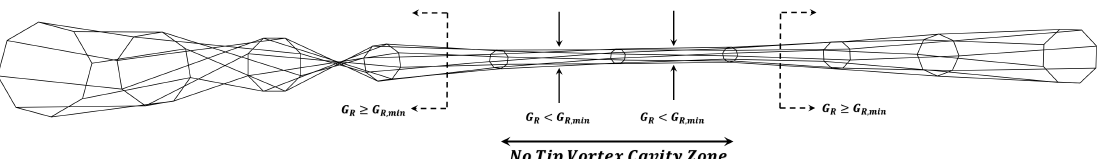
Figure 9. Twisted tip vortex cavity sections before adjustment. The zone over which a tip vortex cavity is not considered is also shown. The criterion to determine the zone with no tip vortex cavity is G R < G R , min